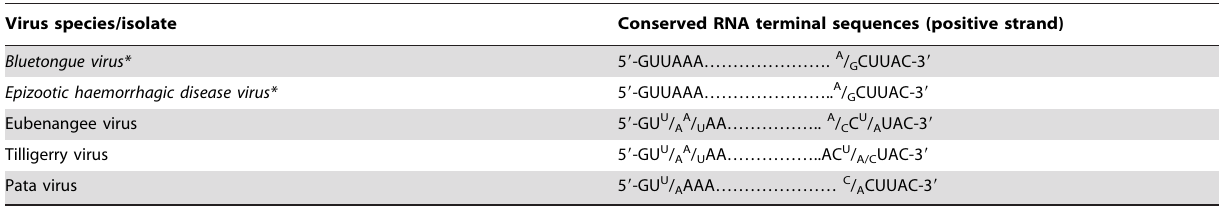
Table 2. Conserved terminal sequences of EUBV, TILV and PATAV genome segments.